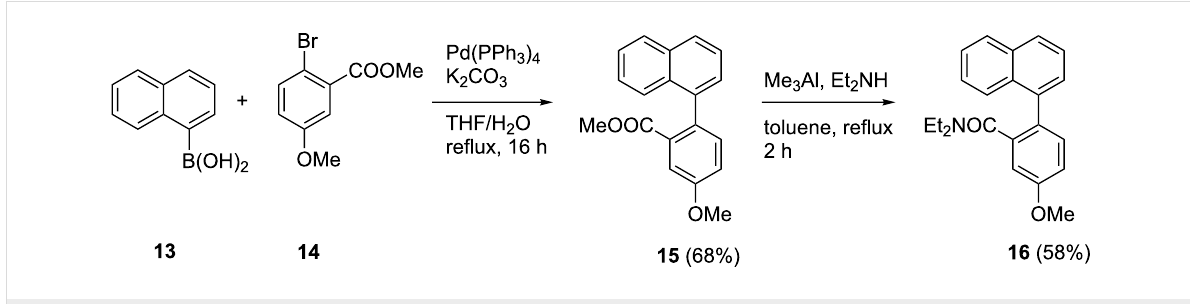
Scheme 7: Synthesis of 1-arylnaphthalene analogues 15 and 16 .